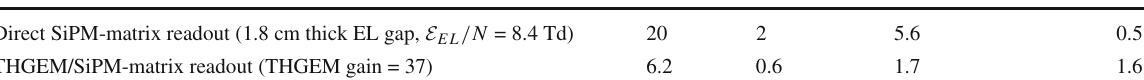
Table 3 Position resolution of two-phase detectors in x , y plane extrapolated from that obtained in this work (using SiPM-matrix readout with 1 cm channel pitch) in comparison with that reported in dark-matter search experiments (using PMT-matrix readout). Also shown is the data for dual-phase Xe TPC with SiPM-matrix readout